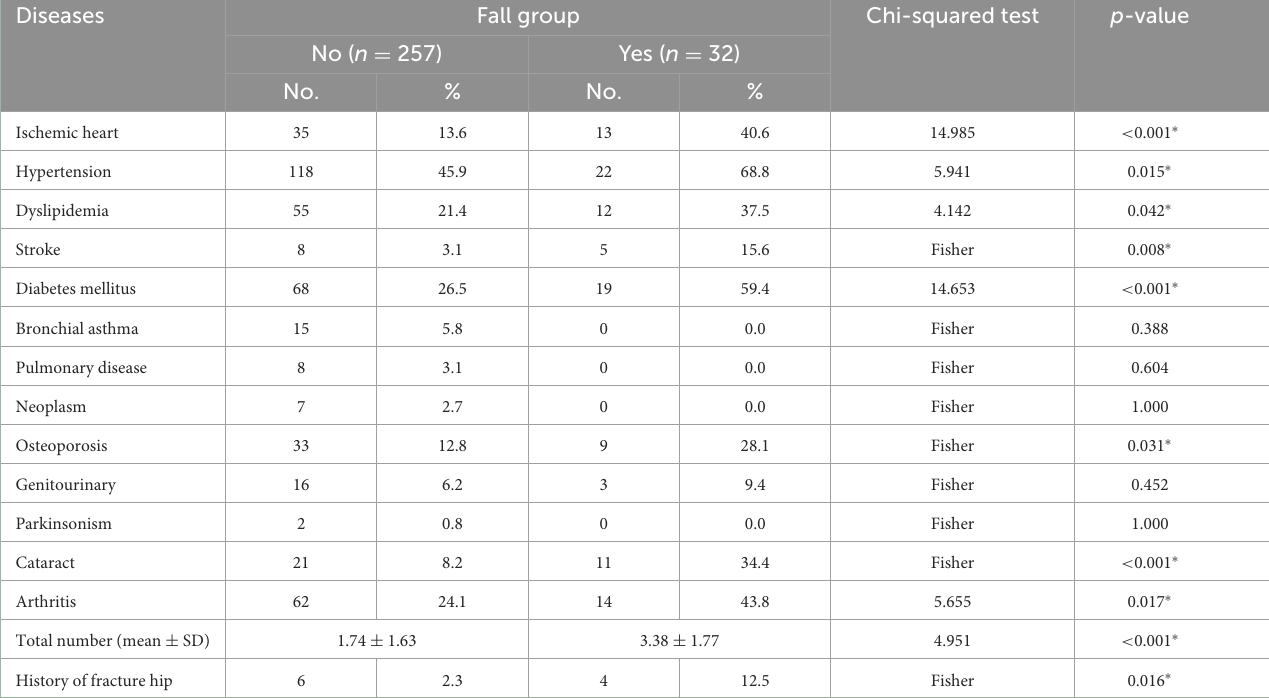
TABLE 3 Comparison of the prevalence of chronic diseases reported by old age persons with and without fall history.